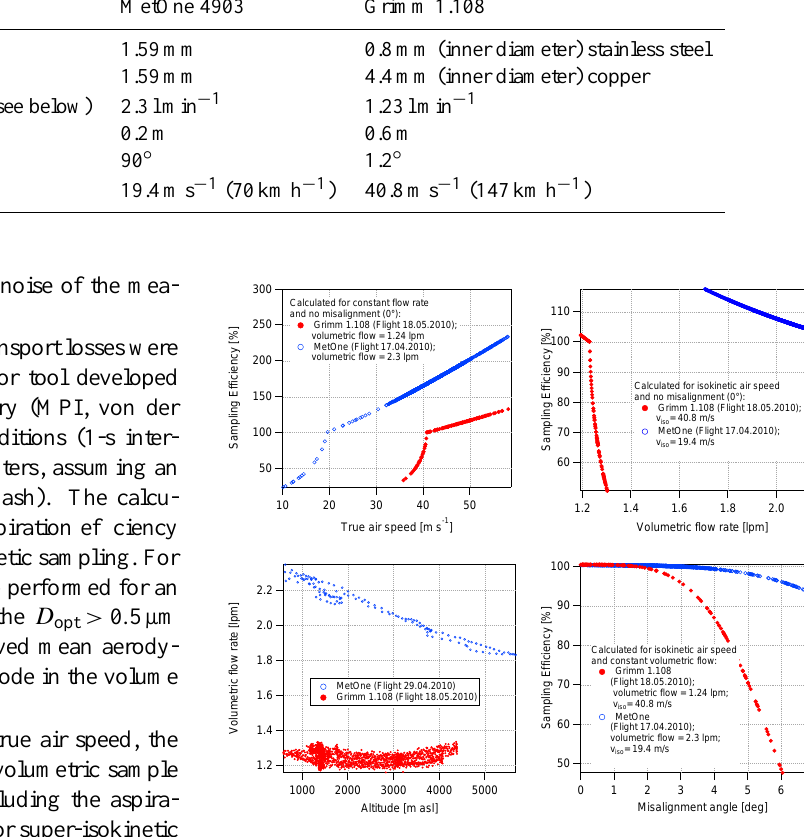
size distributions which were subject to sampling efficien- cies lower than 60 % in the D a = 1–10 µm range were